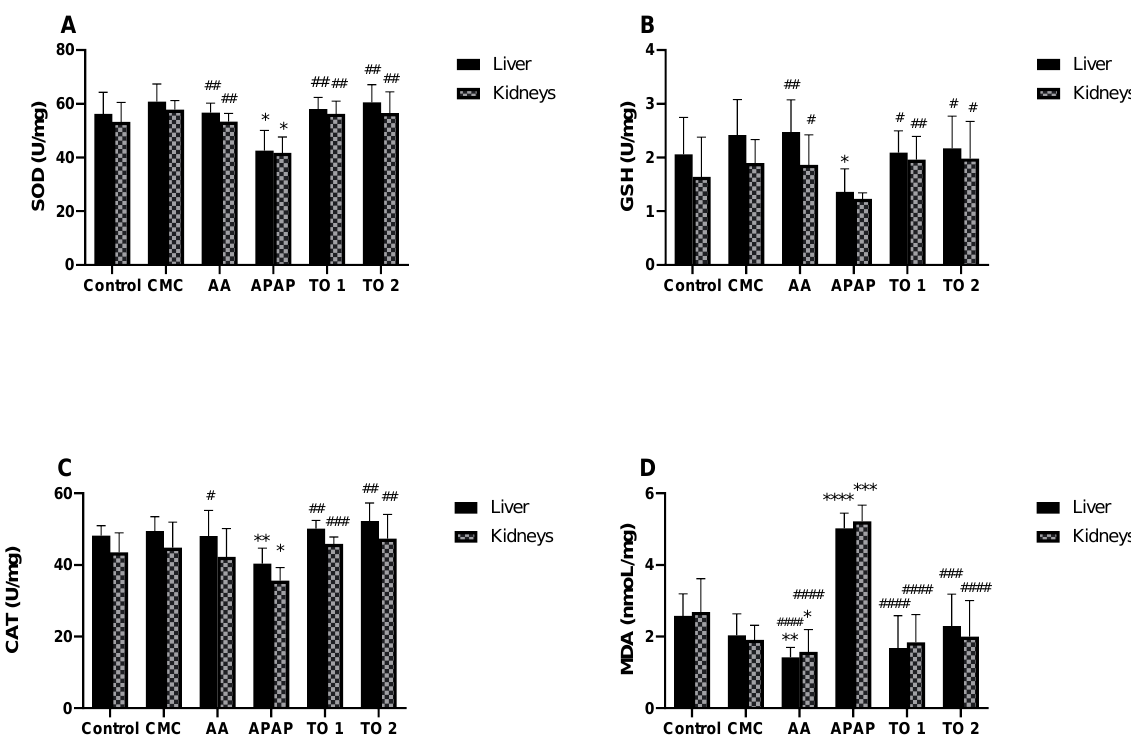
Figure 2. Effect of Taraxacum officinale essential oil on antioxidant enzymes and MDA levels against acetaminophen-induced liver injury in mice. Values are expressed as means ± SD ( n = 5), * p < 0.05; ** p < 0.01; *** p < 0.001; **** p < 0.0001 vs. the normal control group and # p < 0.05; ## p < 0.01; ### p < 0.001; #### p < 0.0001 vs. the toxic control group. ( A ) Effect of Taraxacum officinale EO on SOD level in liver and kidney of APAP-treated mice; ( B ) effect of Taraxacum officinale EO on GSH level in liver and kidney of APAP-treated mice; ( C ) effect of Taraxacum officinale EO on CAT level in liver and kidney of APAP-treated mice; ( D ) effect of Taraxacum officinale EO on MDA level in liver and kidney of APAP-treated mice. SOD: superoxide dismutase; GSH: reduced glutathione; CAT: catalase; MDA: malondialdehyde; AA: ascorbic acid; CMC: sodium carboxymethylcellulose; APAP: aceta-